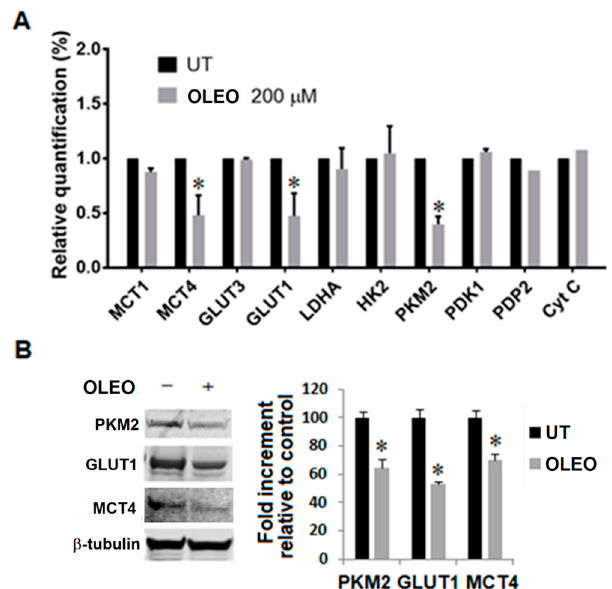
Figure 3. Change in metabolic markers of A375 melanoma cells treated with OLEO 200 μ M for 24 hours. ( a ) Evaluation by quantitative real-time PCR of genes involved in metabolism; ( b ) Representative Western blot panels of PKM2, GLUT1 and MCT4 protein levels. Each band in the Western blot was quanti fi ed by densitometric analysis and the corresponding histogram was constructed by normalizing the density of each band to that of β -tubulin. Values presented are means ± SEM of three independent experiments. Significance is indicated with *.